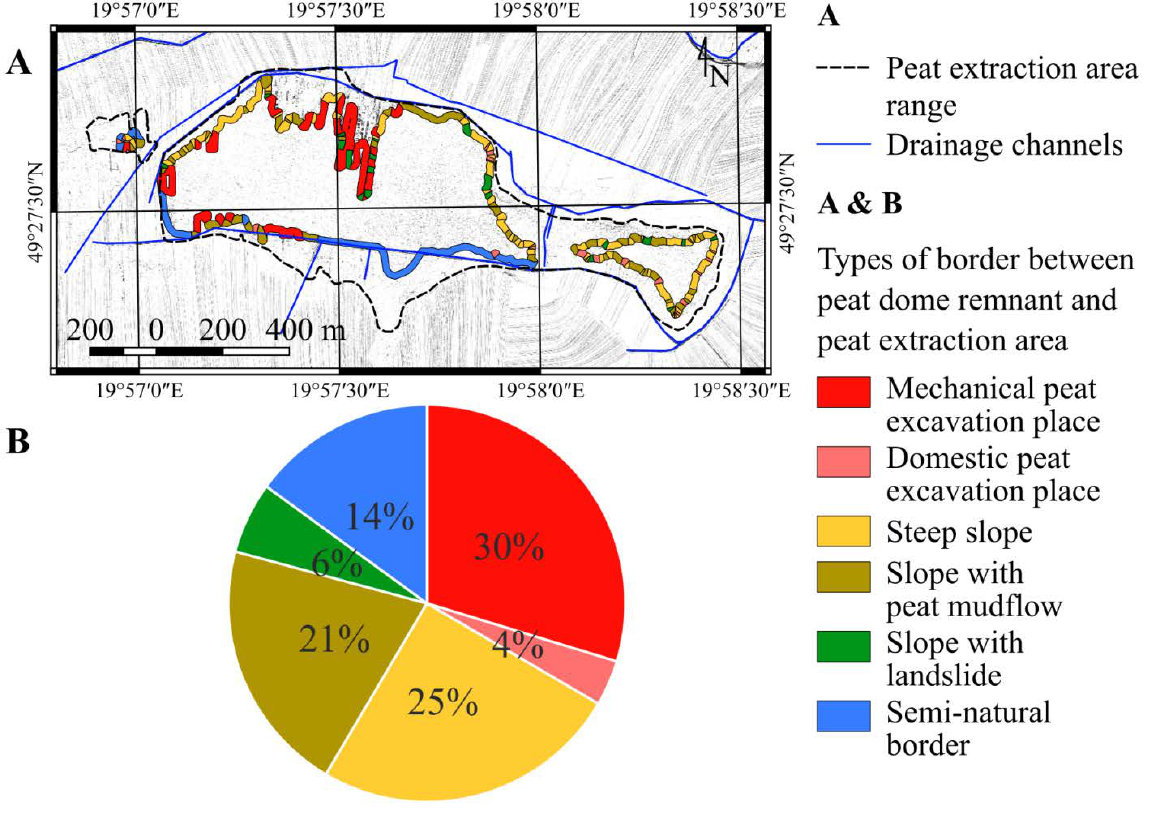
Figure 4. The borders between peat dome remnants and cutover areas. A: map showing the different types of border; B: diagram showing the proportions of different border